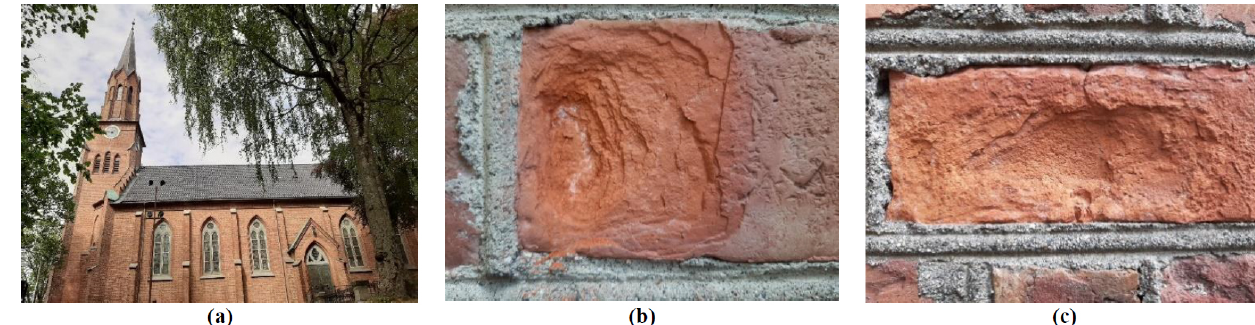
Figure 1. The (a) Tønsberg cathedral and (b) , (c) degraded bricks at its southeast-oriented